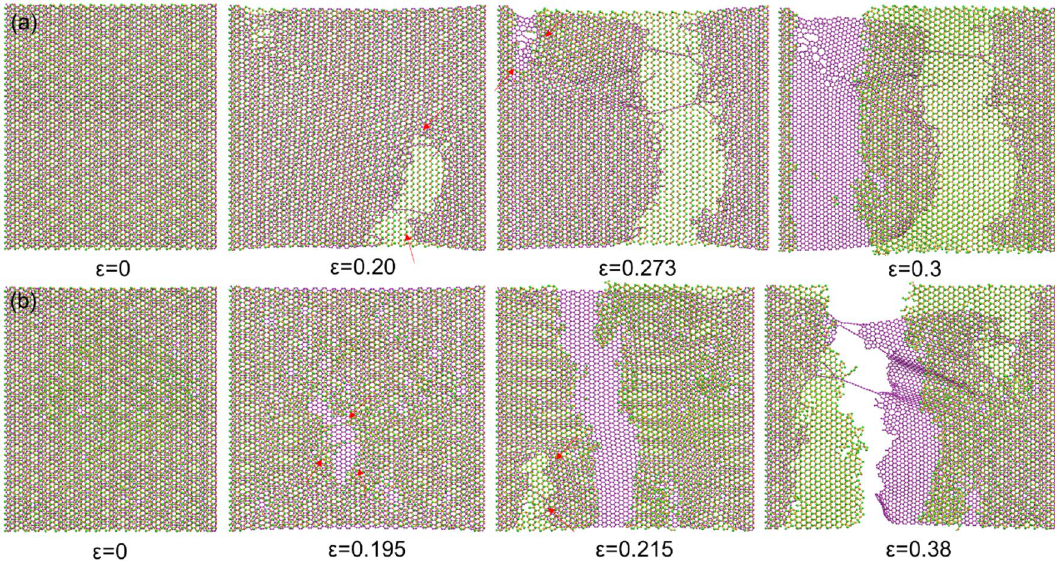
Figure 9. Typical configurations of the MoS 2 /graphene heterostructure under different tensile strains. ( a ) Original MoS